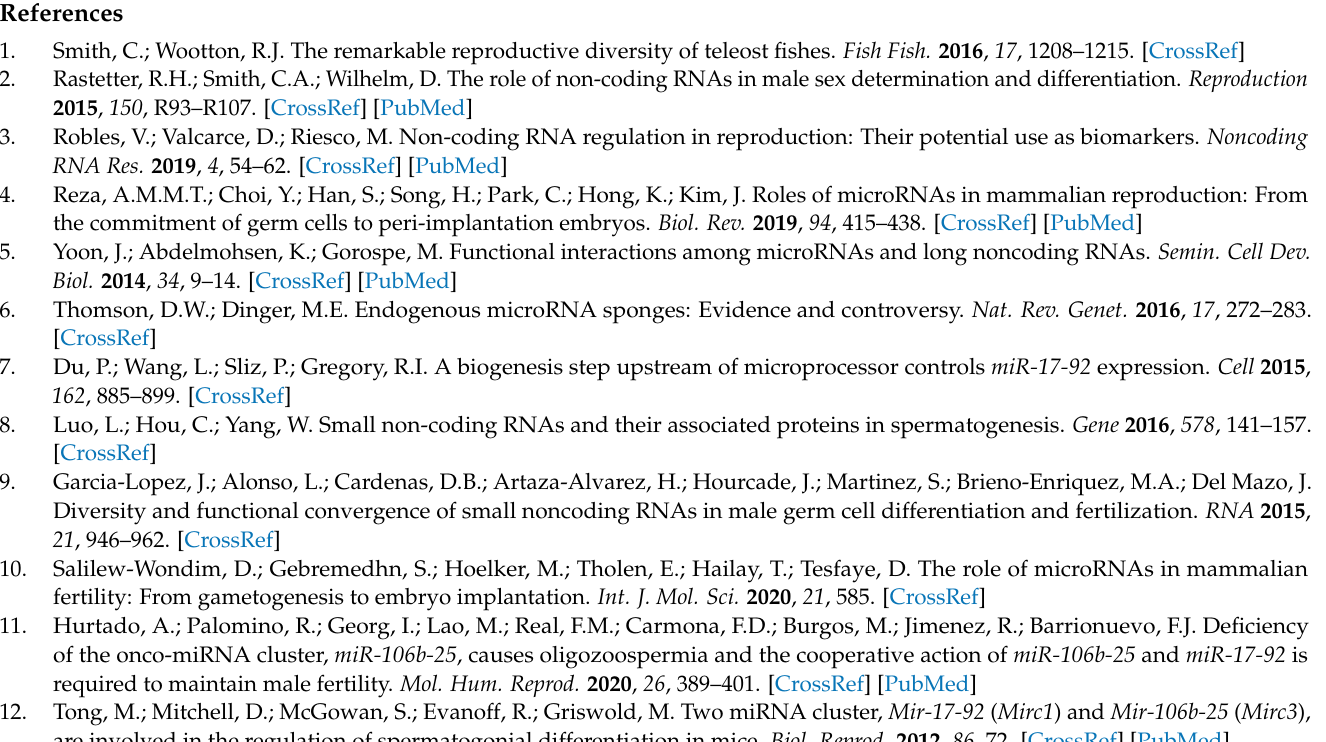
(c) miRNAs from sequencing analysis; Table S4: GO and KEGG classification of up- and down- DEmRNAs; Table S5: GO and KEGG classification of mRNAs colocalized (cis-) and co-expressed (trans-) with DElncRNAs; Table S6: GO and KEGG classification of predicated targets of DEmiRNAs; Table S7: qRT-PCR analysis for selected DEmRNAs, DElncRNAs and DEmiRNAs; Table S8: mRNA– miRNA–lncRNA network analysis; Table S9: GO and KEGG classification of ceRNAs; Table S10: GO and KEGG classification of predicated targets of let-7; Table S11: Luciferase activity for dual-luciferase reporter assay; Figure S1: Synteny analysis of let-7 clusters in vertebrates. The pentagon’s direction indicates the gene direction compared with the reference gene; Figure S2: Differential expression of let-7 cluster members from small RNA-seq